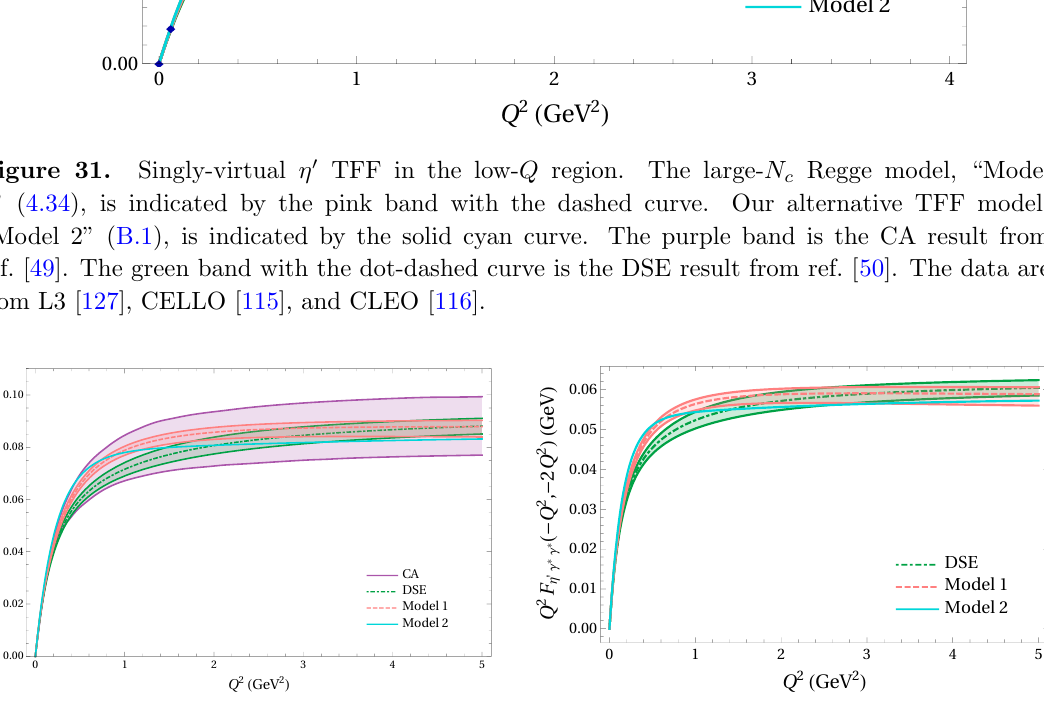
Figure 32. Doubly-virtual (cid:17) 0 TFF in the symmetric region Q 2 where Q 2 = Q 2 and Q 2 = 2 Q 2 (right). Legend is the same as in (cid:12)gure 1 2